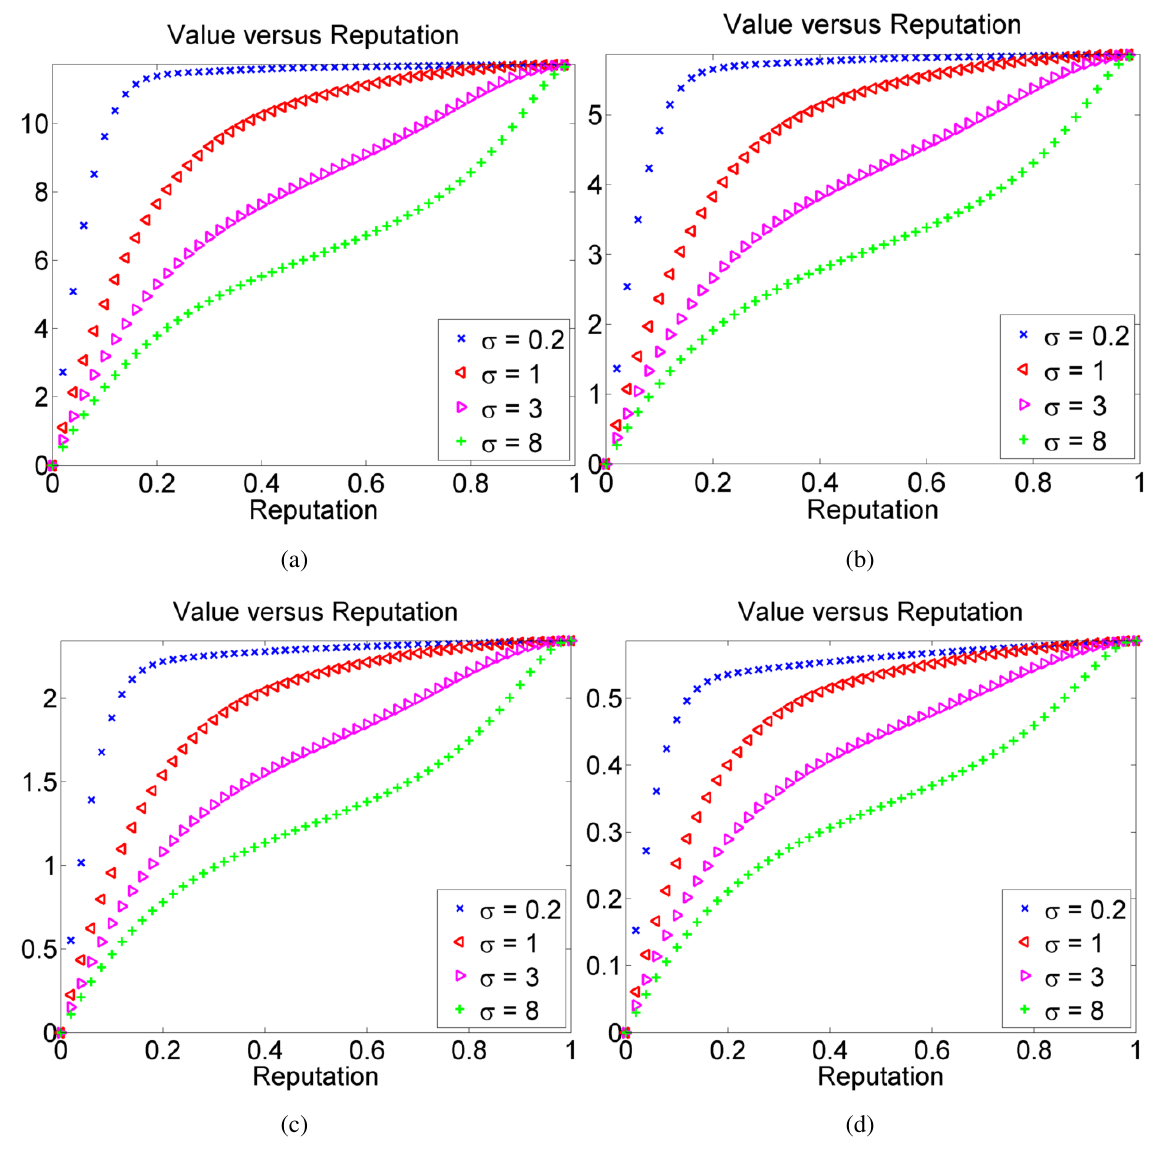
Figure 5. The same as Figure 3, but with κ = 1 . ( a ) ρ = 0 . 1 ; ( b ) ρ = 0 . 2 ; ( c ) ρ = 0 . 5 ; ( d ) ρ = 2 . 0